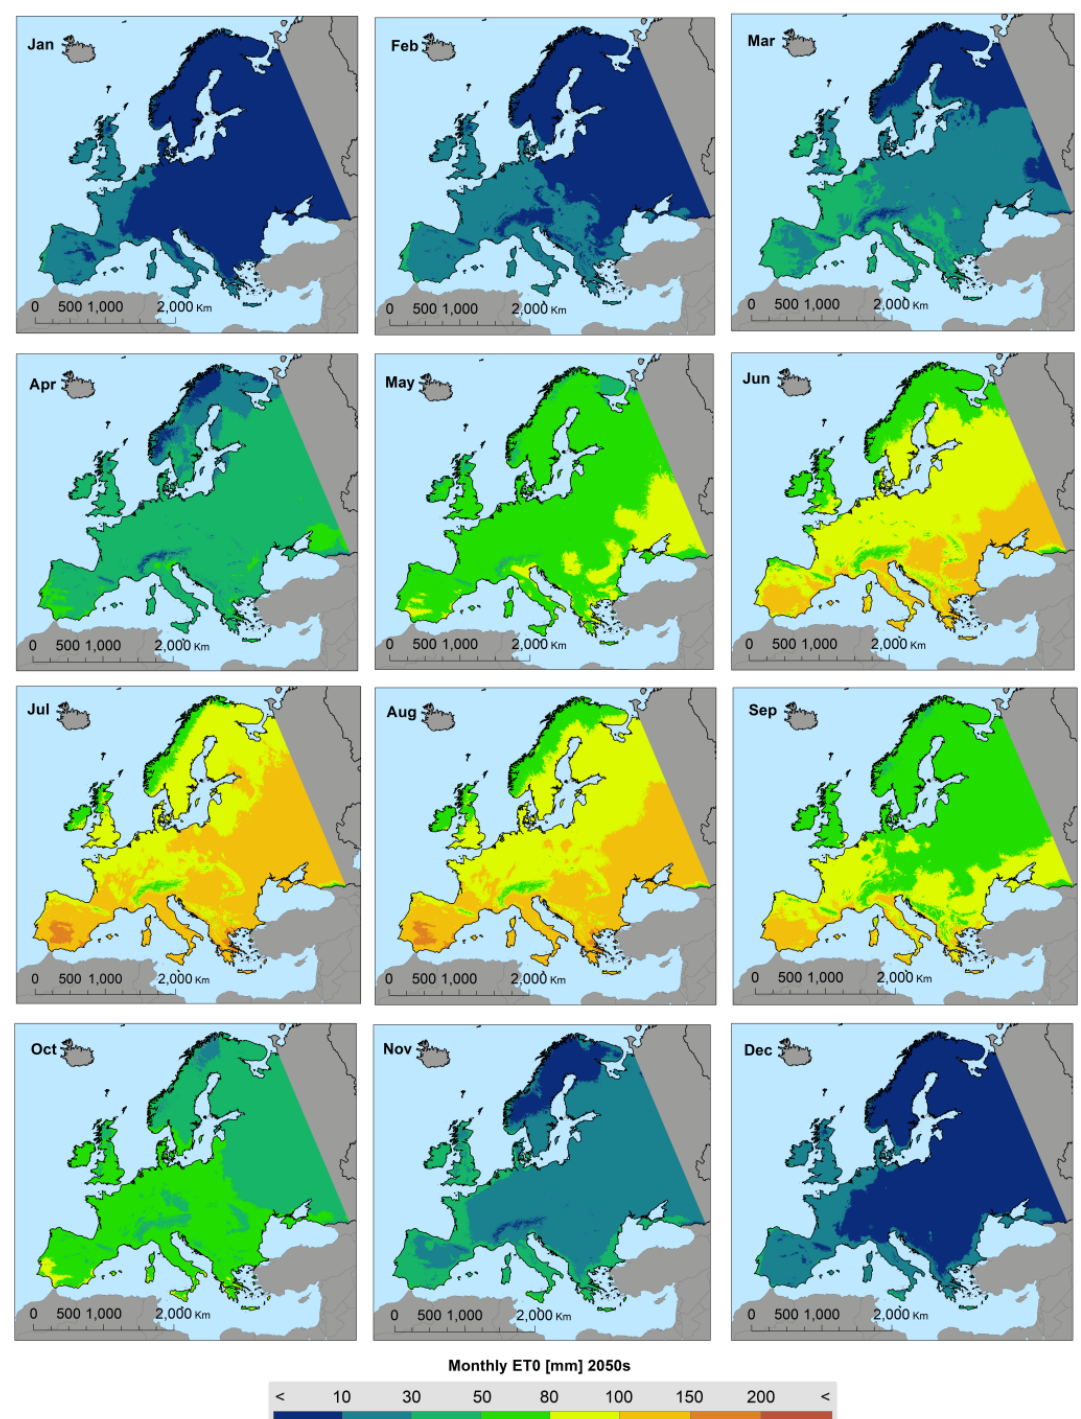
Figure 6. Spatial distribution of monthly ET0 over Europe during 2050s.